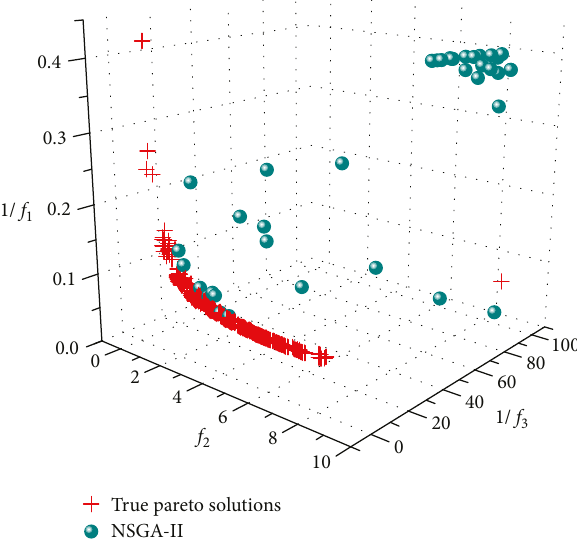
Figure 6: Plots of the true PSs and the fi nal PSs found by NSGA-II on the speci fi c instance.